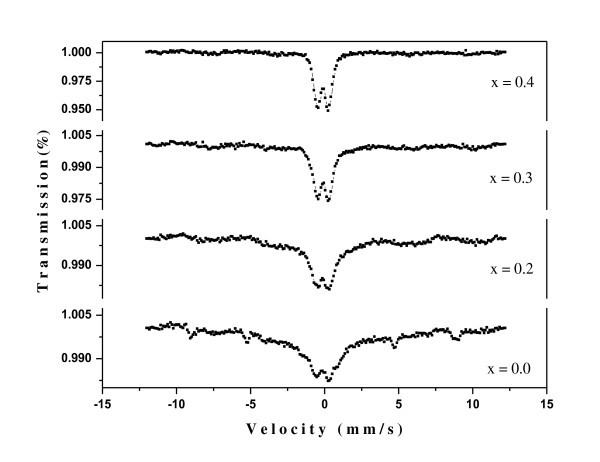
Mössbauer pattern of Ni0.2Cd0.3Fe2.5 - xAlxO4 (0.0 ≤ x ≤ 0.5) ferrite nanoparticles at 300 K.